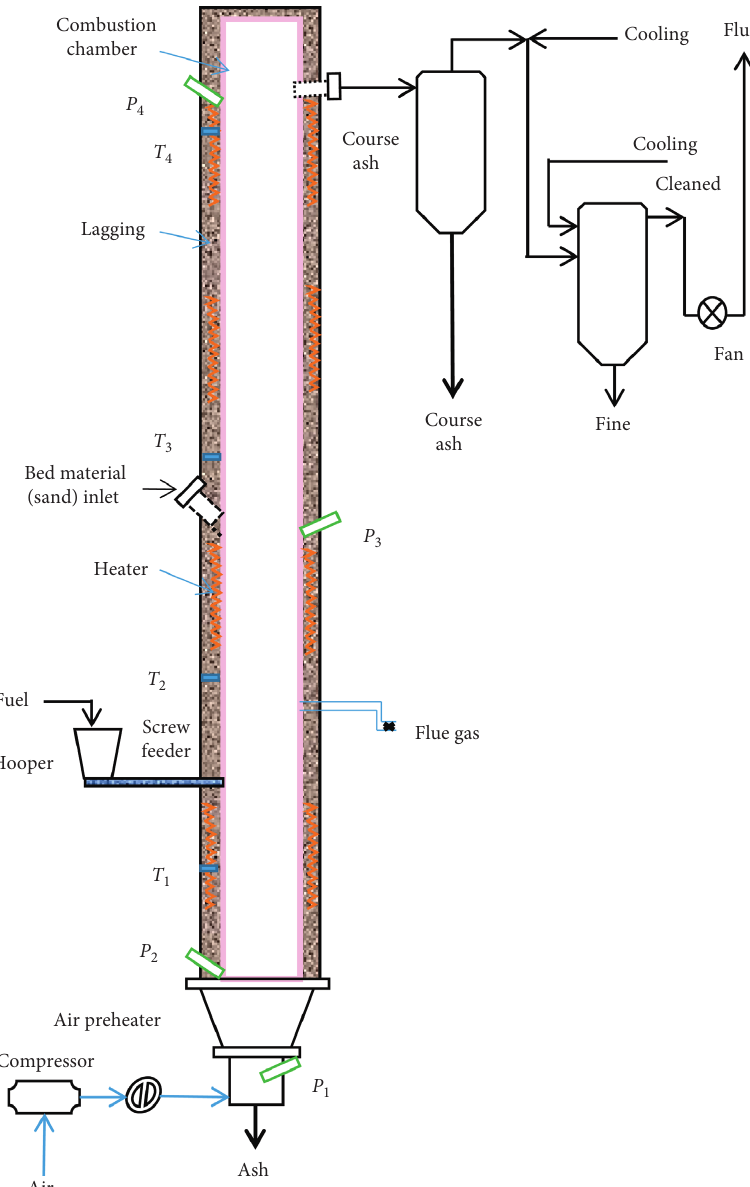
Figure 1: Schematic diagram of FBC.